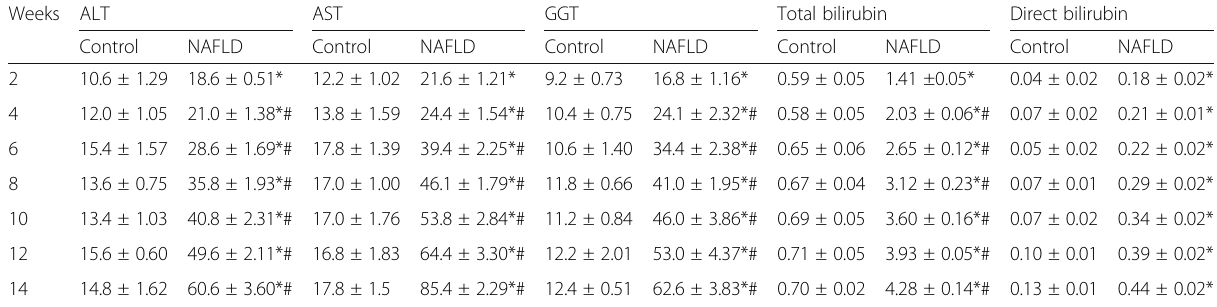
Data expressed as mean ± SE *Significant difference compared to control group at the same duration period by t test ( P < 0.05) #Significant difference compared to the previous duration in the same group by paired t test ( P <